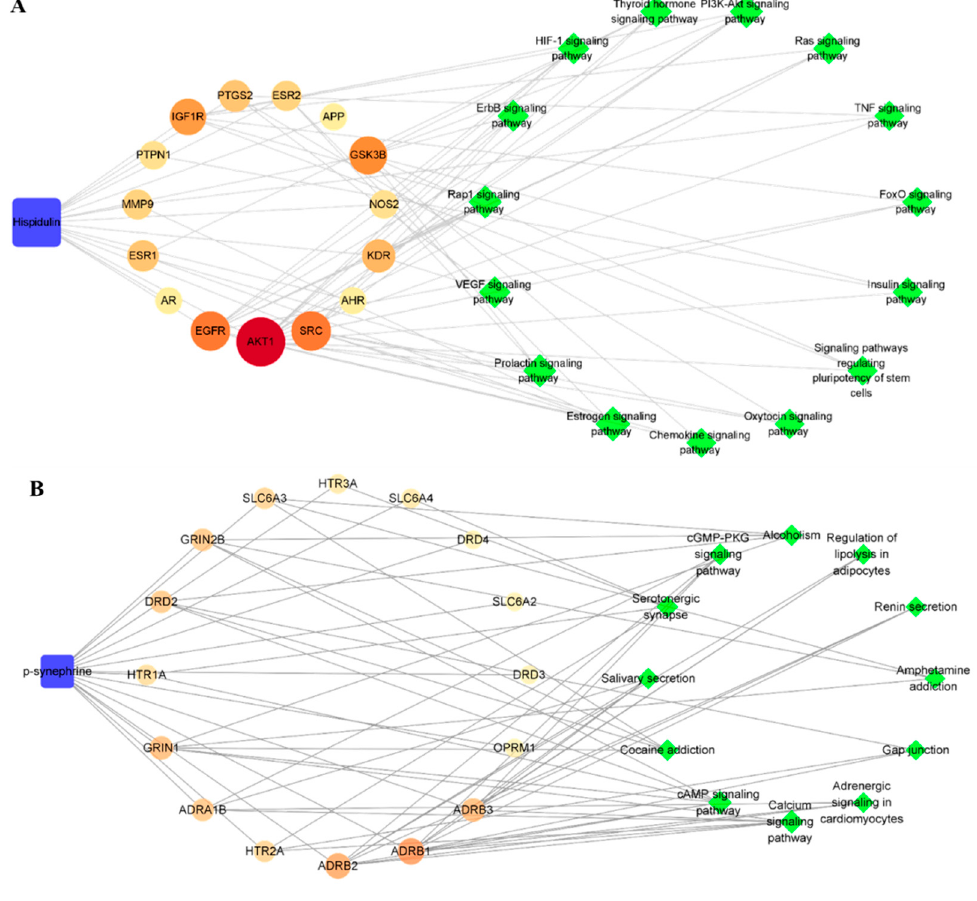
Figure 5. Integrated compound–target–pathway (C–T–P) networks. ( A ) C–T–P network of his- pidulin. ( B ) C–T–P network of p -synephrine. ( C ) Combination C–T–P network of hispidulin and p - synephrine. As shown in Figure 5A, the hispidulin C–T–P network consisted of 31 nodes (1 com- pound node, 15 key target nodes, and 15 pathway nodes) and 74 edges. Among the key target nodes, AKT1 , SRC , EGFR , and GSK3B showed high degree values of 15, 9, 9, and 8, respectively. In the pathway nodes, estrogen, prolactin, Rap1, and PI3K-Akt signaling pathways exhibited the degree values of 6, 5, 5, and 5, respectively. In Figure 5B, the p -synephrine C–T–P network formed 1 compound node, 16 key tar- get nodes, 12 pathway nodes, and 63 edges. In particular, ADRB1 , ADRB2 , GRIN1 , and ADRB3 showed high degree values of 9, 8, 6, and 6, respectively. Among these, ADRB1 , ADRB2 , and ADRB3 were the key targets that clustered in the PPI network analysis. In addition, these targets were connected to the calcium and cAMP signaling pathways, which had the highest degree values among the pathway nodes. The combination C–T–P network consisted of 60 nodes (2 compound nodes, 31 key target nodes, and 27 pathway nodes) and 137 edges, as shown in Figure 5C. As shown in the combination network, there were no shared key targets or pathways among the pre- dicted key targets and pathways. These results suggest that hispidulin and p -synephrine might exhibit anti-obesity effects through different mechanisms of action. 3.2. Inhibitory Effects of Hispidulin and p-Synephrine on Adipogenesis in 3T3-L1 Preadipocytes The cytotoxicity of hispidulin, p -synephrine, and co-treatment with hispidulin and p - synephrine in 3T3-L1 preadipocytes was evaluated using the Ez-Cytox cell viability assay kit. The cell viability assay showed that concentrations up to 40 μ M hispidulin and 40 μ M